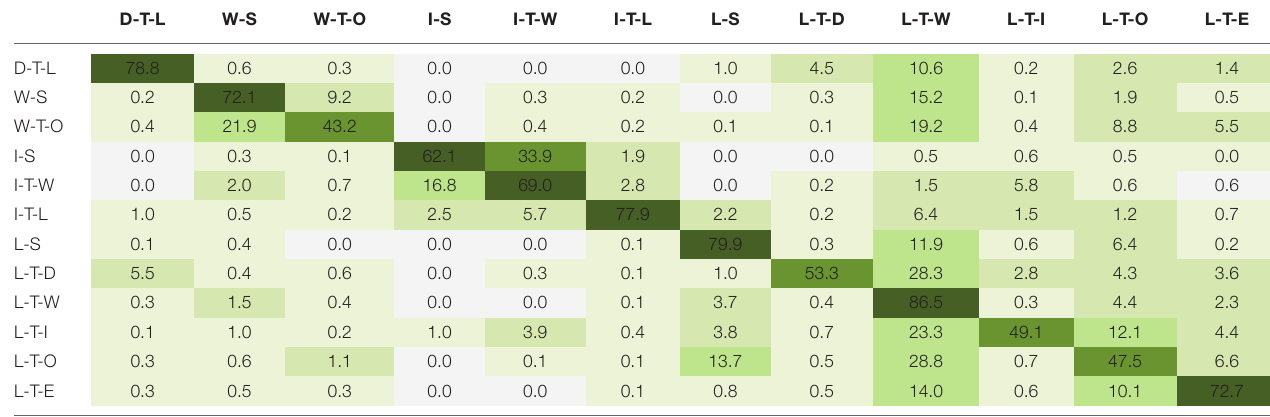
The columns and rows are the predicted and labeled classes, respectively.